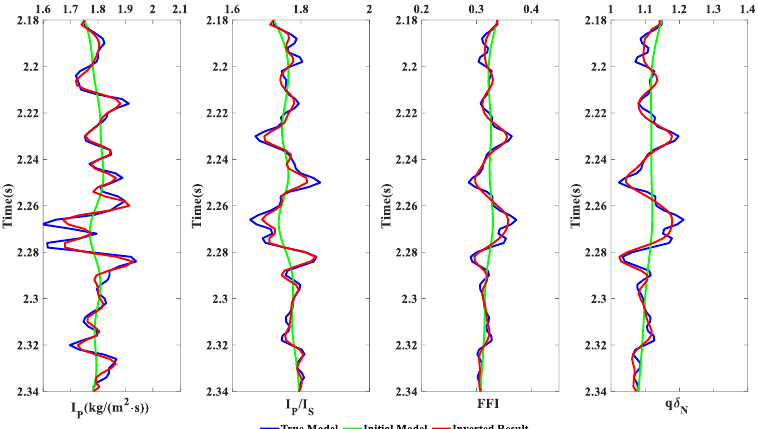
Figure 4. The inverted results of model parameters without noise.